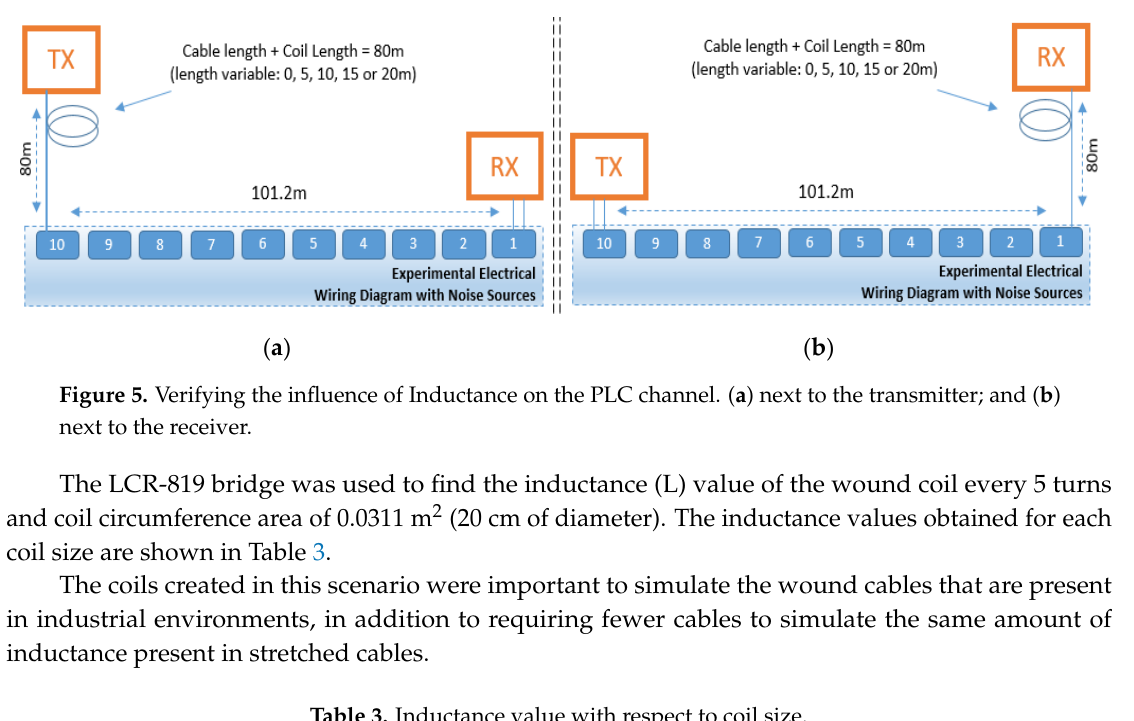
Table 3. Inductance value with respect to coil size.